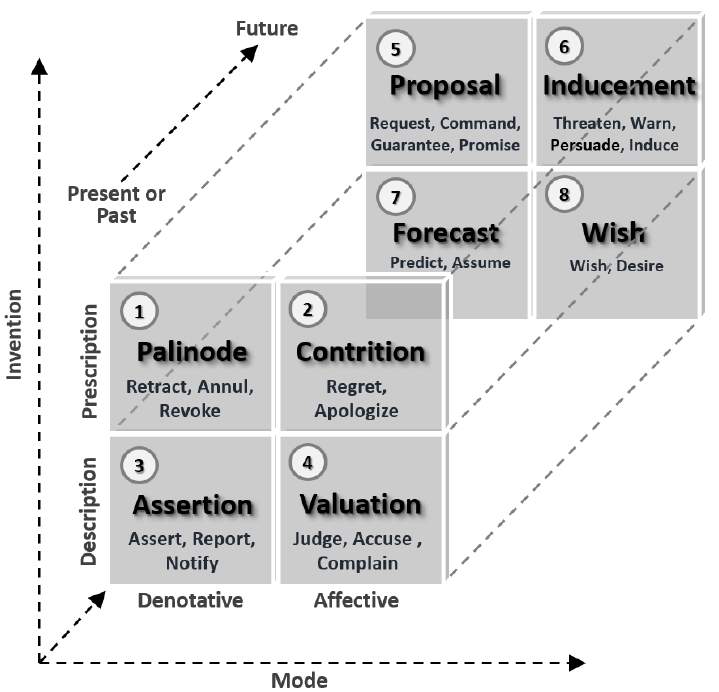
Figure 1. Illocution classification framework (adapted from Liu